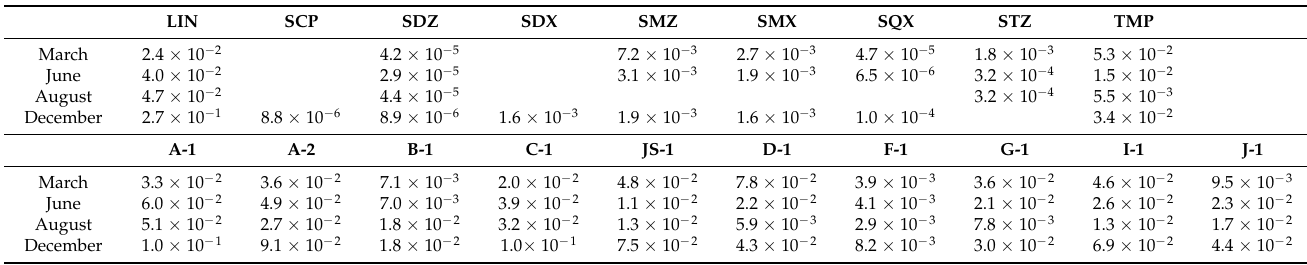
Table A7. Risk assessment for resistance to antibiotics in the surface water samples. Blank cells indicate samples where no antibiotic could be detected.